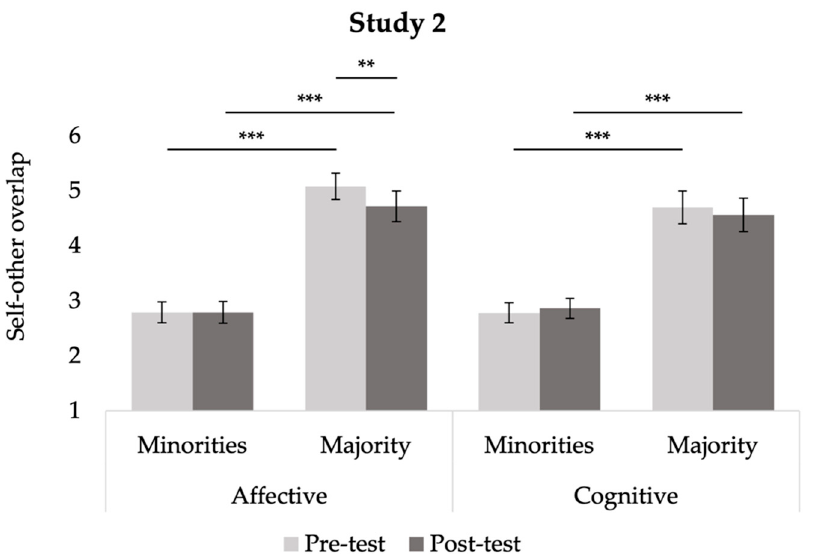
Figure 6. Plot depicting participants’ self-other overlap with minorities and majorities at pre-test and post-test within each condition in Study 2. * p < 0.05, ** p < 0.01, *** p < 0.001.